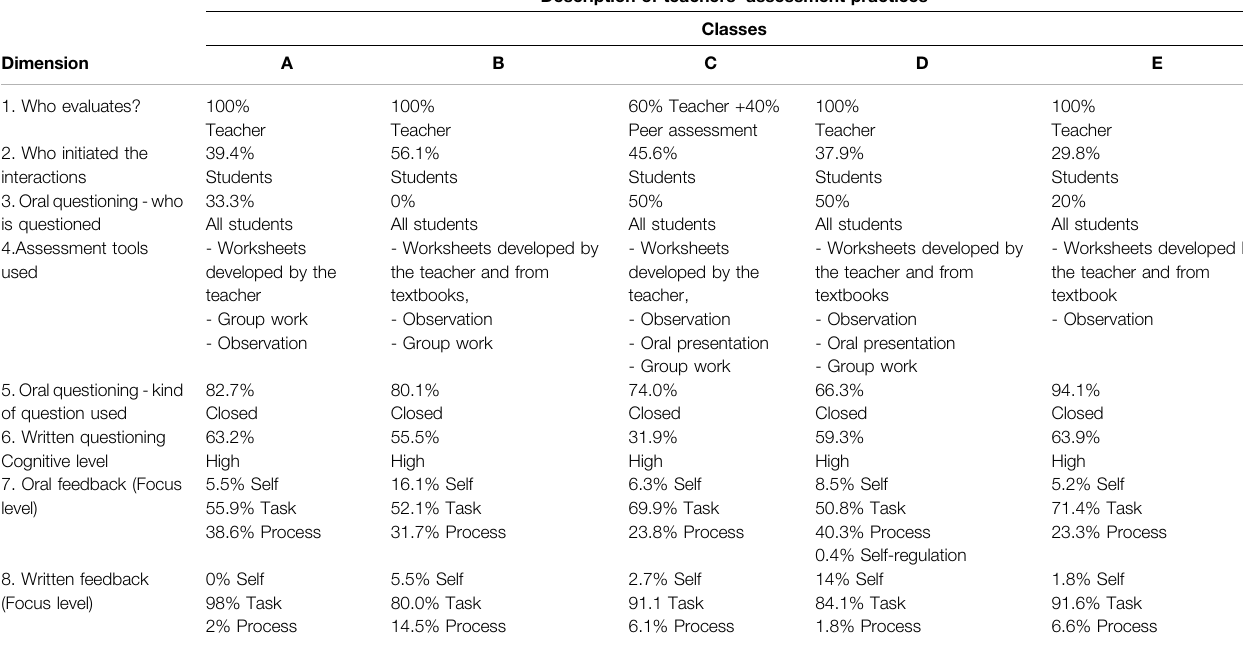
TABLE 5 | Overview of teachers ’ assessment